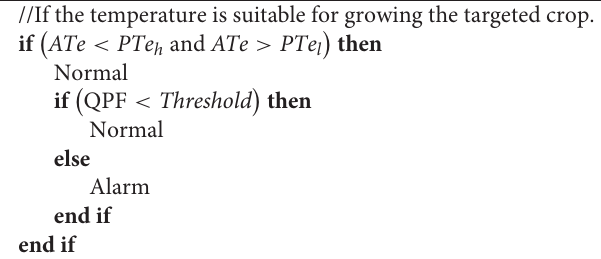
Algorithm 2: Farm Environmental Detection